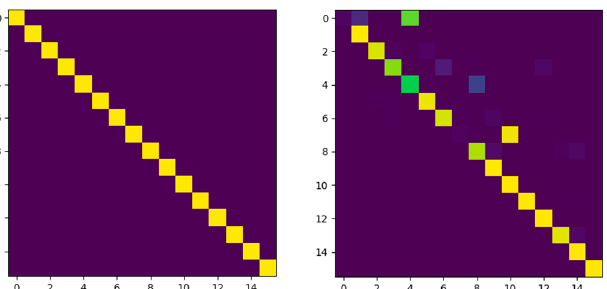
Figure 2. The label distribution ζ and the correlation distribution ϕ . The intensity of the color indicates the strength of the correlation; the strongest is 1, and the weakest is 0. The ordinate indicates the position of each patch in the original image, the abscissa indicates the position of each patch in the matching image, and the row indicates the correlation between a certain patch in the original image and all patches in the matching image. If the original image and matching image are equal, each row is unimodal. Rows being multimodal means that the patch is ambiguous and hard to